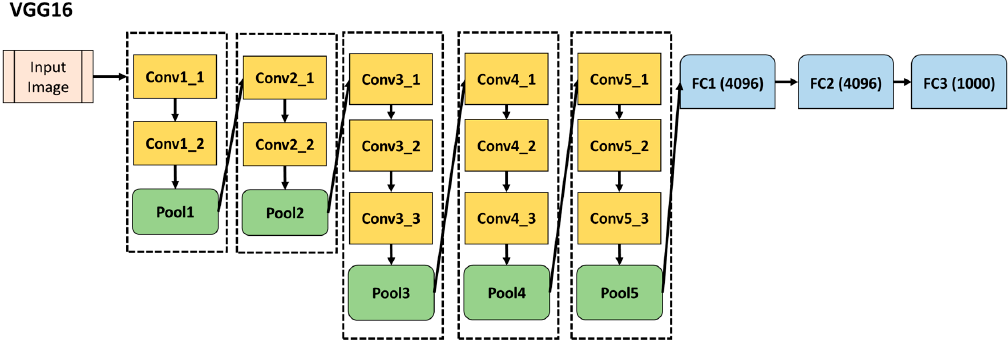
Figure 4. A simplified version of the architecture of VGG16 neural network showing the different convolutional (Conv), pooling (Pool), and fully connected (FC) layers. Like AlexNet, the VGG16 convolutional neural network has seen rapid growth in applications